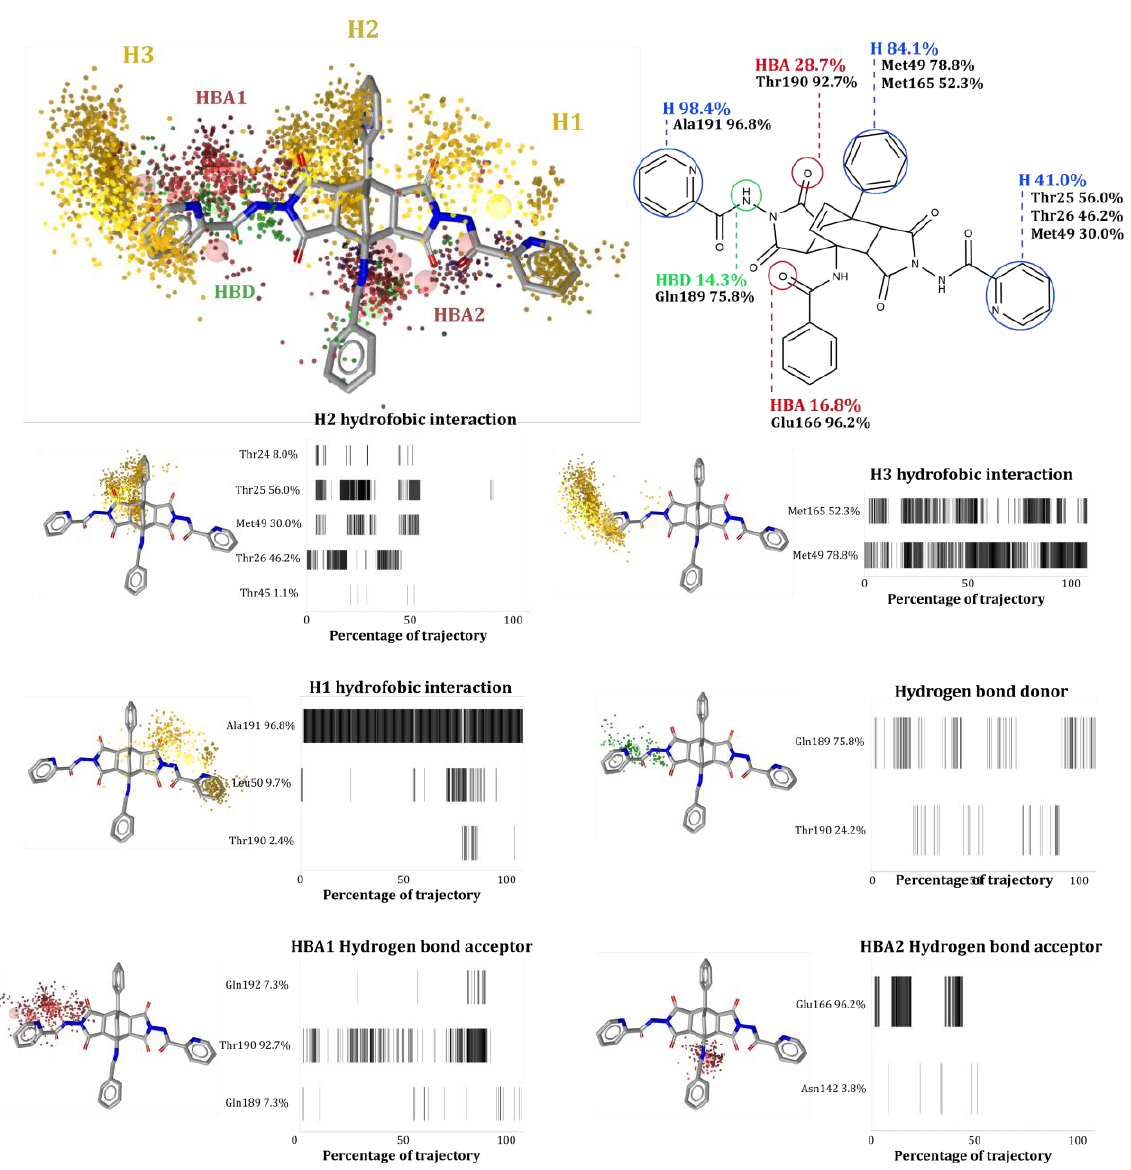
Figure 5. Dynophore model of the bicyclo[2.2.2]octene 11a in the SARS-CoV-2 3CL pro active site. Top row: (left) 3D dynophore model with point clouds representing the distribution of the obtained superfeatures; (right) detailed 2D schematic depiction of the interaction patterns with amino acid residues and statistical information. Bottom: sequential and statistical schemes of the most important single super-element of the dynophore model. Yellow dots represent hydrophobic element; red ones represent hydrogen bond acceptor features; and green ones hydrogen bond donor features.